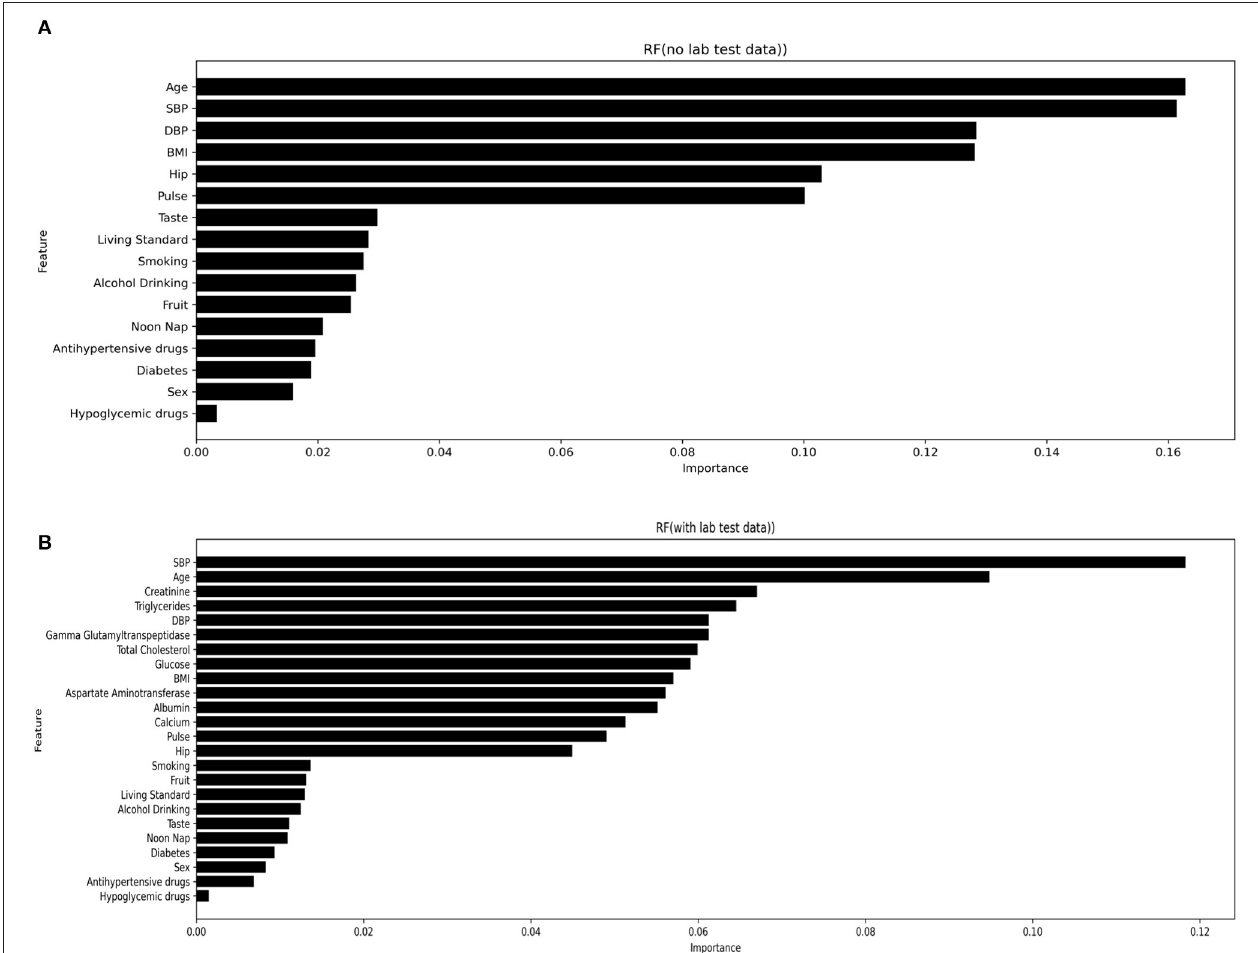
FIGURE 3 | Most important variables from RUS-applied RF with both inclusion (A) and exclusion (B) of laboratory